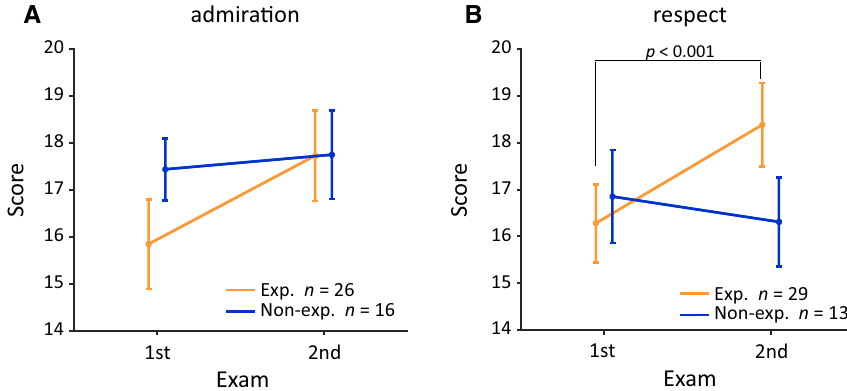
Fig. 5 Scatter plots showing the relationship between emotion rating difference (the lecturer minus the inter- viewer) and score increment (second exam score minus first exam score) in each sub- category of respect. Note that each point was jittered slightly to visualize overlap. A The plot of keiai (adoration). There was no significant Spearman’s cor- relation ( rs = 0.18, p = 0.249). B The plot of shinsui (worship). There was no significant cor- relation ( rs = 0.26, p = 0.097). C The plot of ifu (awe). We found significant correlation between rating difference and score increment ( rs = 0.38, p = 0.014), suggesting that experiencing ifu is involved in improving exam performance. Note that Bonferroni-adjusted α was set at 0.017 (= 0.05/3) to correct the FWE of three correlation tests. Asterisk (*) indicates a significant differ- ence ( p <